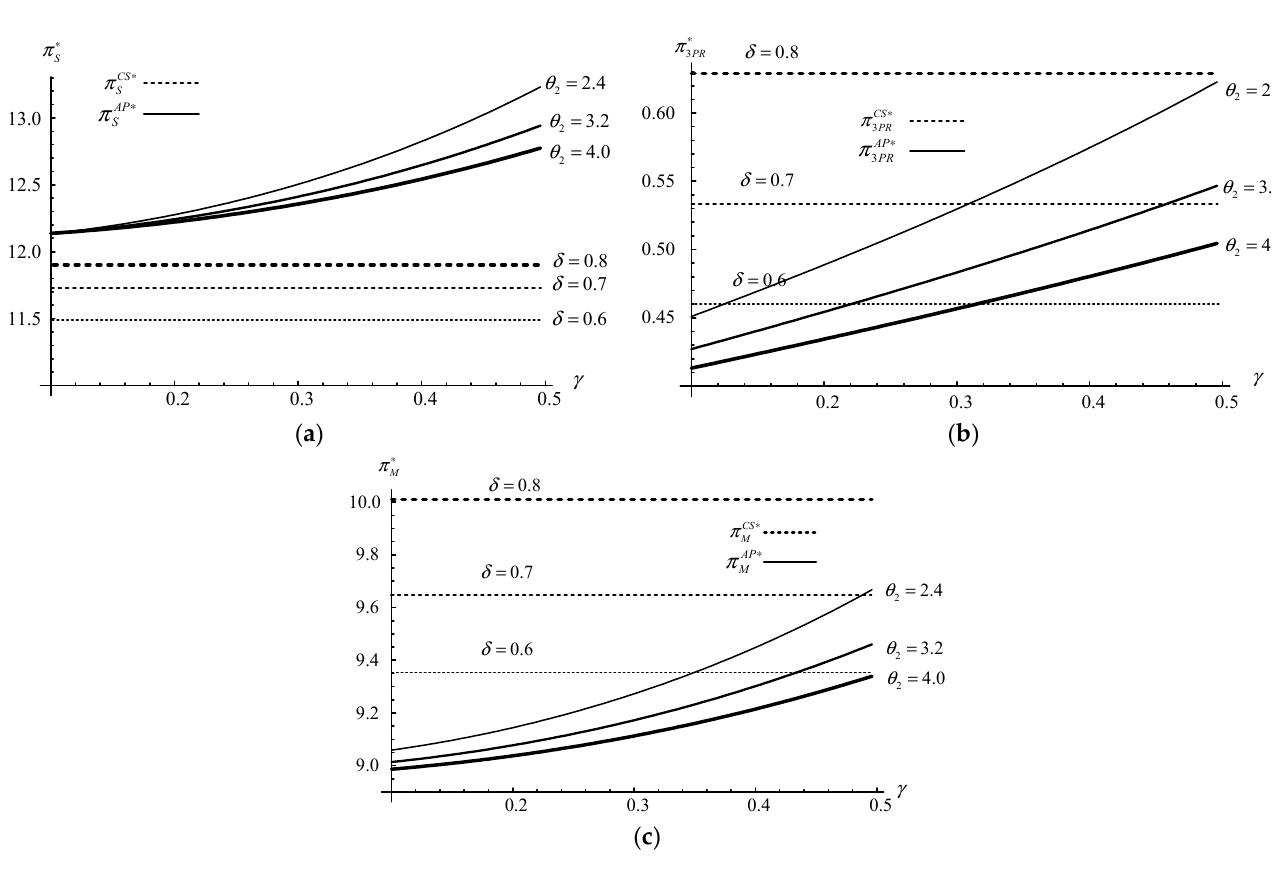
Figure 6. The firms’ profits vs. θ 2 , δ , γ . ( a ) The supplier’s profit vs. θ 2 , δ , γ . ( b ) The 3PR’s profit vs. θ 2 , δ , γ . ( c ) The manufacturer’s profit vs. θ 2 , δ , γ